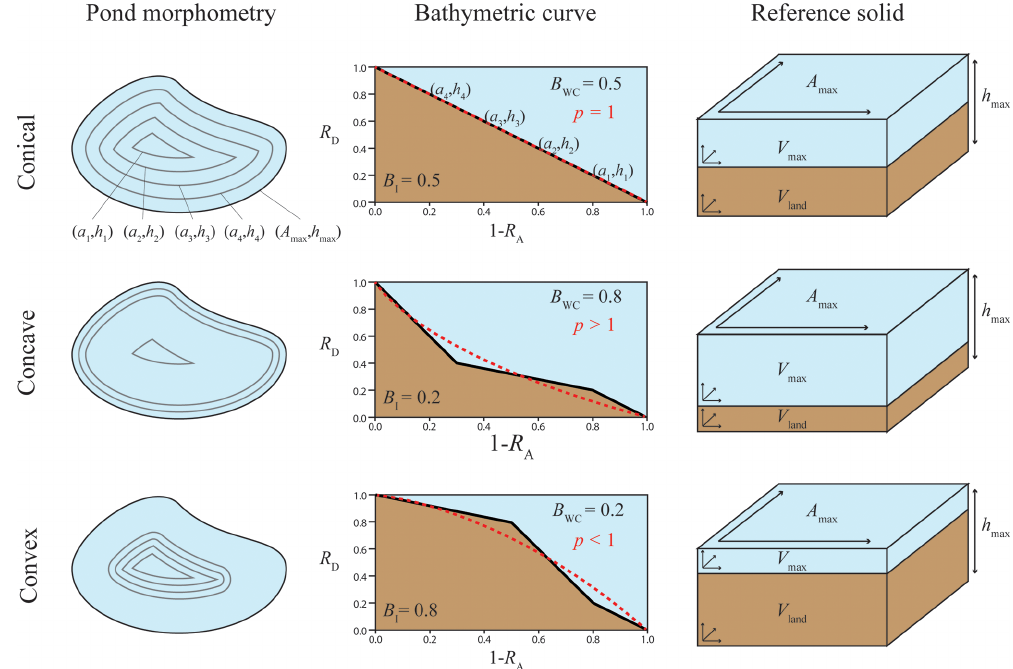
Figure 1. Perceptual diagram of the relationship between morphometric variables. The area ( a ) at a given stage of the pond ( h ) is a point on the bathymetric curve (thick black line), where R A is the relative area and R D is the relative depth. The bathymetric integral ( B I ) is the integration of everything below the bathymetric curve and the pond’s capacity to store water ( B WC ) is the integration of everything above the bathymetric curve. The morphometry ( p ) coefficient represents the shape of the bathymetric curve in the power function equation (red- dashed line; Eq. 7). The reference solid is the box created by multiplying the maximum height of the dam ( h max ) by the maximum surface area created by the pond ( A max ), and is entirely comprised of land ( V land ) and/or water ( V max ) proportional to B I and B WC